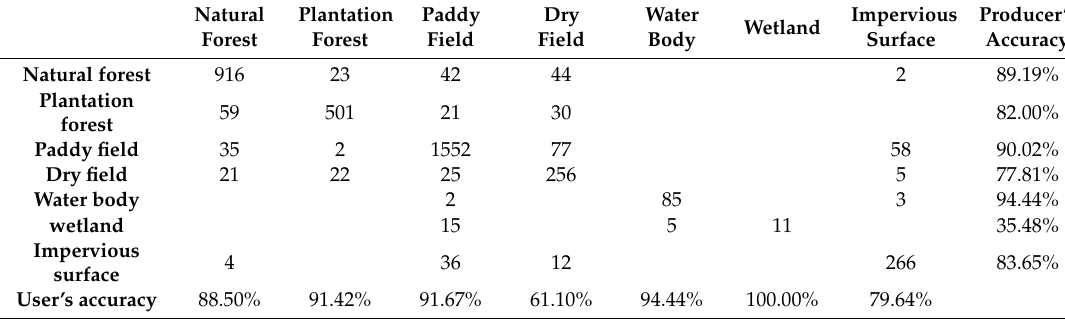
Table 4. Confusion matrix for SBTM classification.